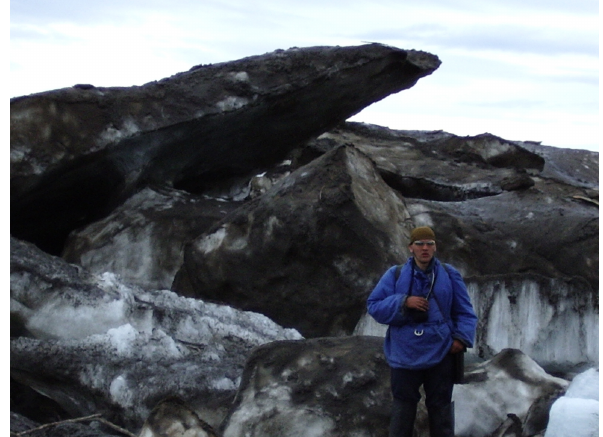
Figure 10. Ice on the sands of Sistyakh-Ariyta Island after a flood (photo by I. Fedorova).